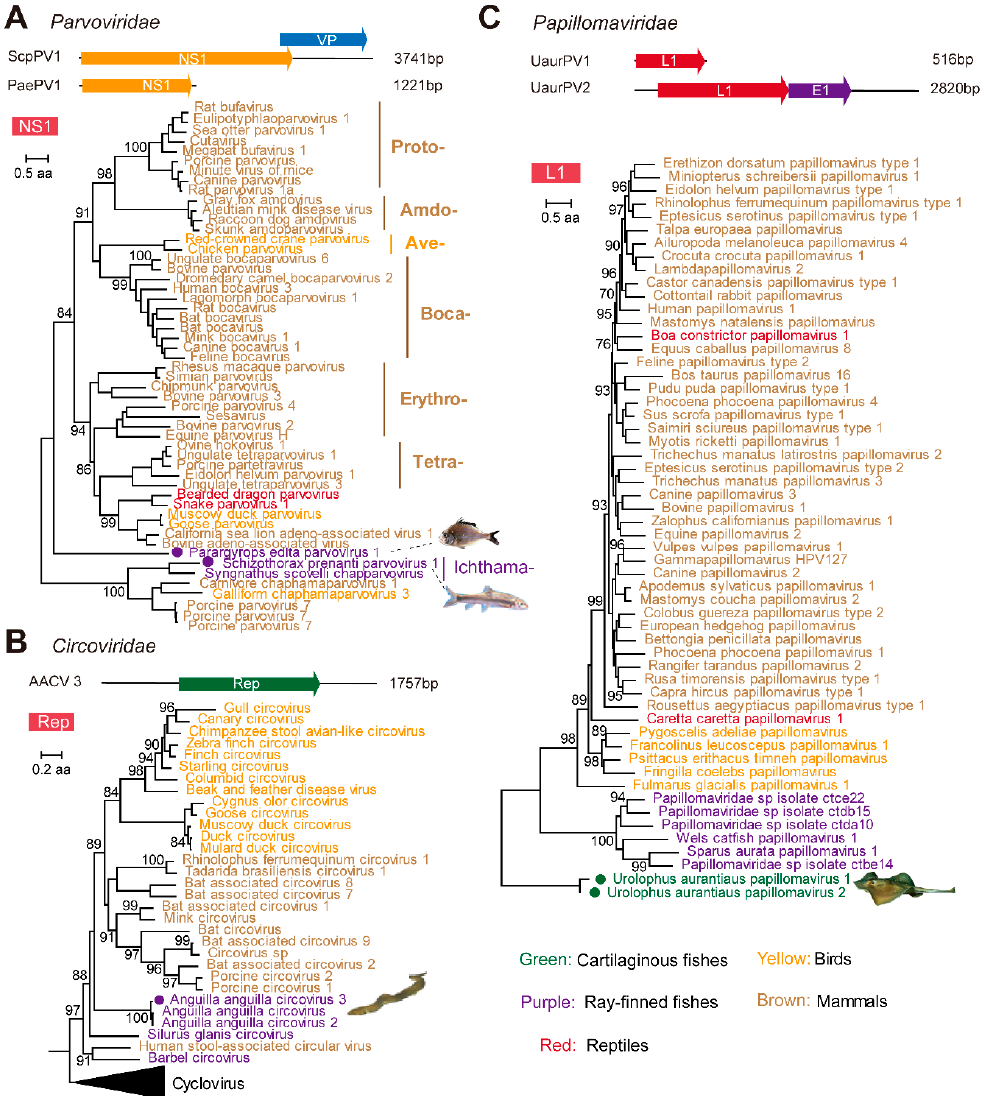
Figure 3. Genomic structures and evolutionary histories of novel small DNA viruses detected from metatranscriptomics and transcriptomics libraries. These include five potential new viruses from three families—namely ( A ) Parvoviridae , ( B ) Circoviridae , and ( C ) Papillomaviridae . The phylogenetic trees were reconstructed based on non-structural protein 1 (NS1), replicase protein, and L1 protein, respectively. All trees are midpoint rooted and scaled to the number amino acid substi- tutions per site. The virus names are color coded to reflect their host group. The positions of newly discovered viruses are shown in solid red circles in each tree and the host. Branch support values (>70%) are shown at the key nodes. All of the genomic structures are shown above the corresponding phylogenetic tree and the potential proteins or protein domains they encode are labeled in the predicted ORFs of these genomes.